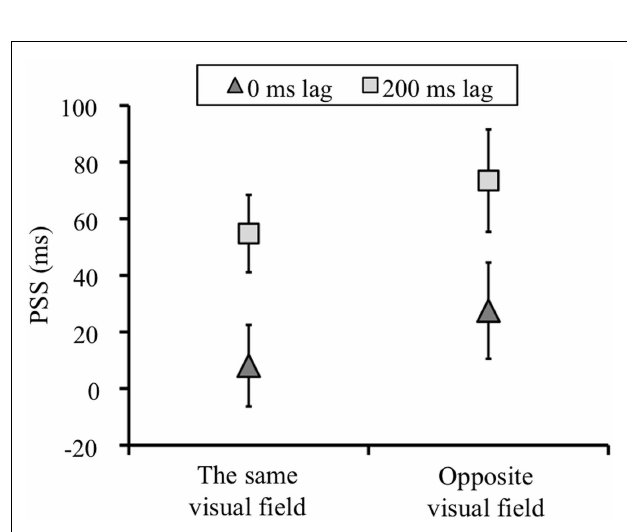
FIGURE 4 |The means of the PSSs (ms) in each condition. Negative values in PSS indicates a test stimulus before a keypress. Error bars show standard error of